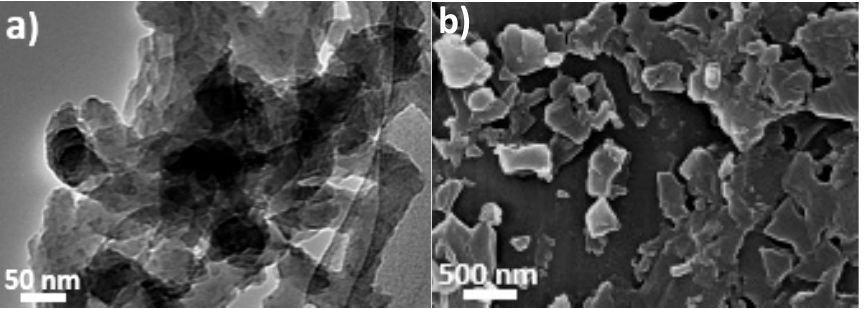
Figure 2. Morphologies of PANI materials obtained when ( a ) the CTAB was absent, or ( b ) FeCl 3 instead of APS was used as the oxidative reagent. The other conditions are the same as that for Figure 1.